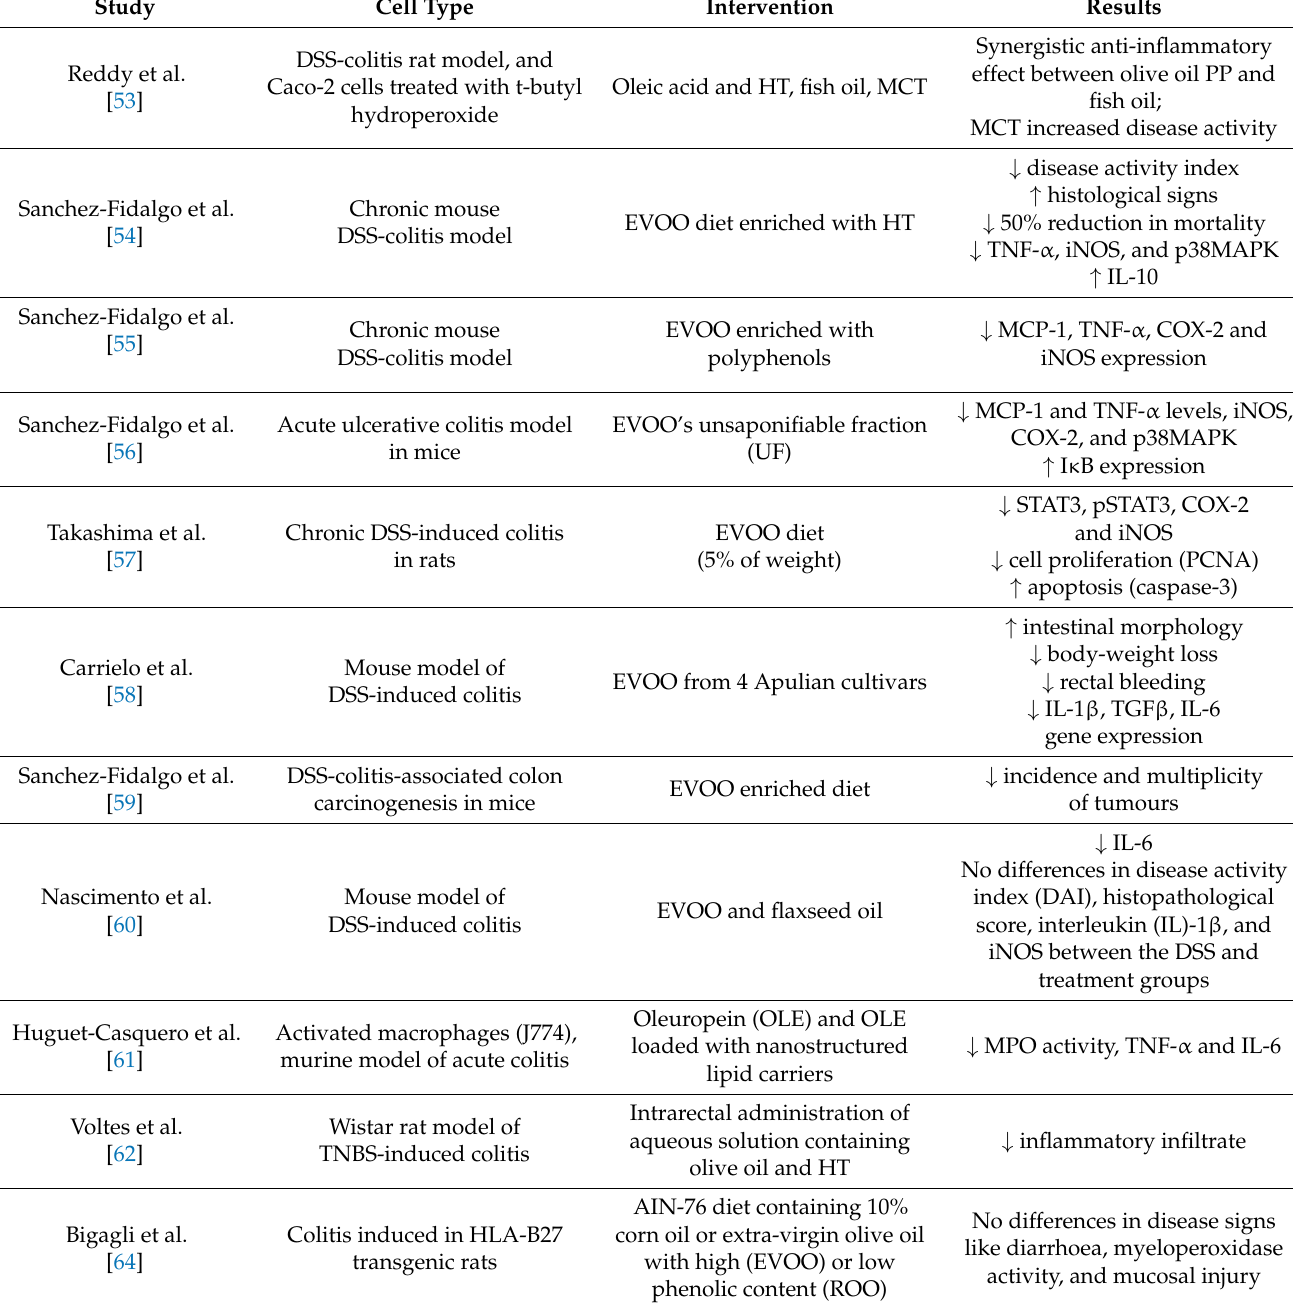
Table 2. Animal studies on olive oil polyphenols and intestinal